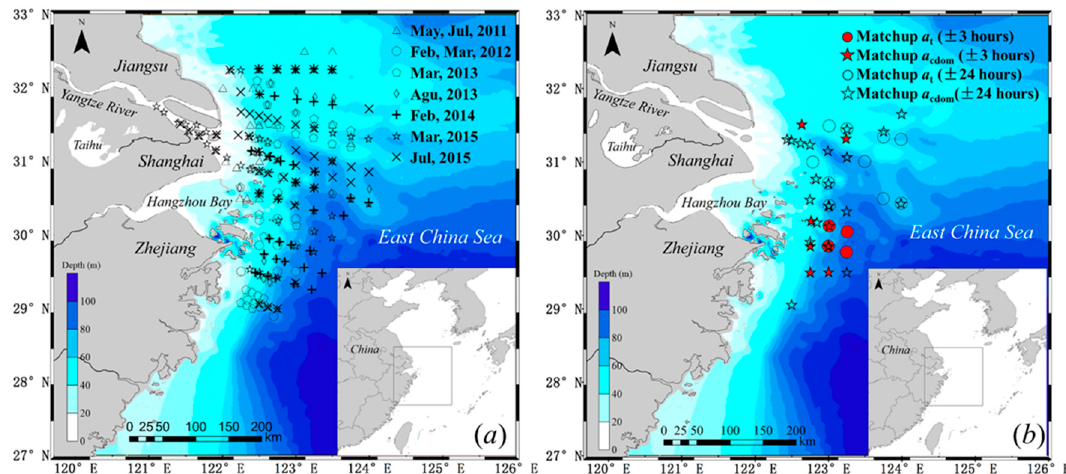
Figure 1. Location of sampling stations in the Changjiang estuarine and coastal waters. ( a ) Samples were collected from 9 cruises in summer (May, July 2011, August 2013 and July 2015) and winter (February, March 2012, March 2013, February 2014 and March 2015); ( b ) Matchup stations selected for in situ and GOCI images (empty circles and stars represent the matchup time windows within ±24 h, filled circles and stars within ±3 h).